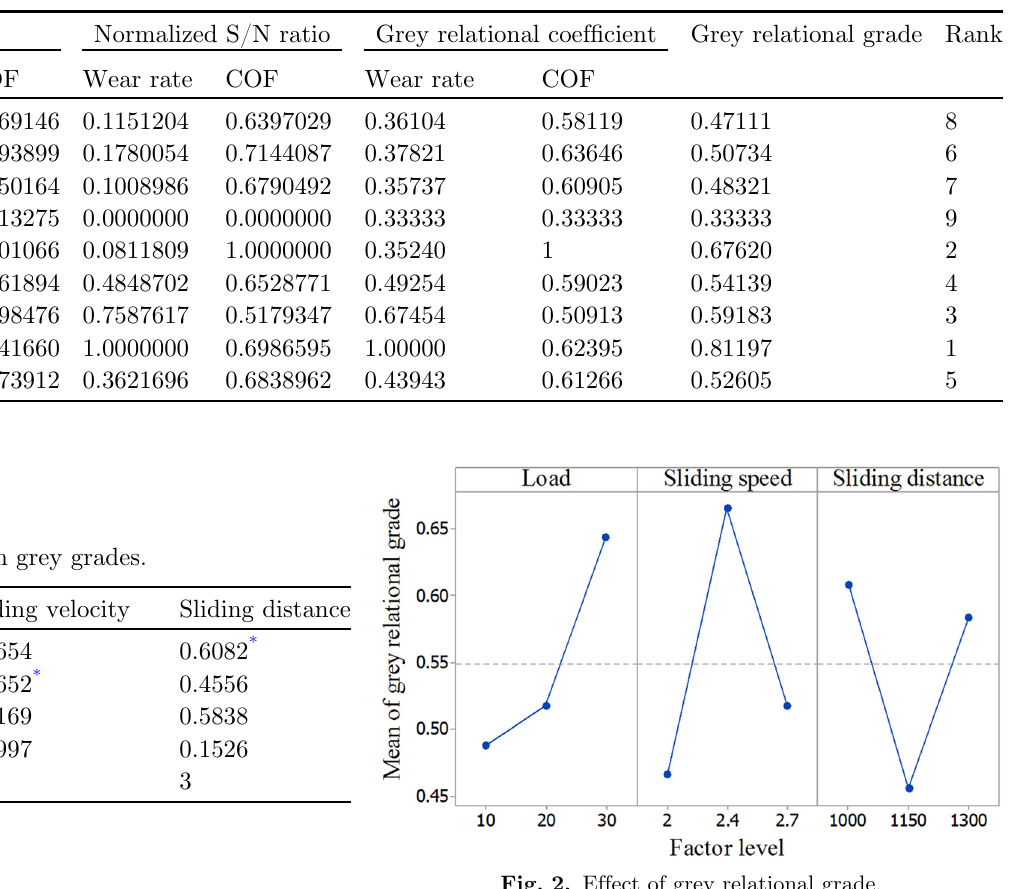
Table 5. S/N ratio, Normalized S/N ratio of wear rate and COF along with Grey relational coef fi cient, Grey relational Grade and Rank.